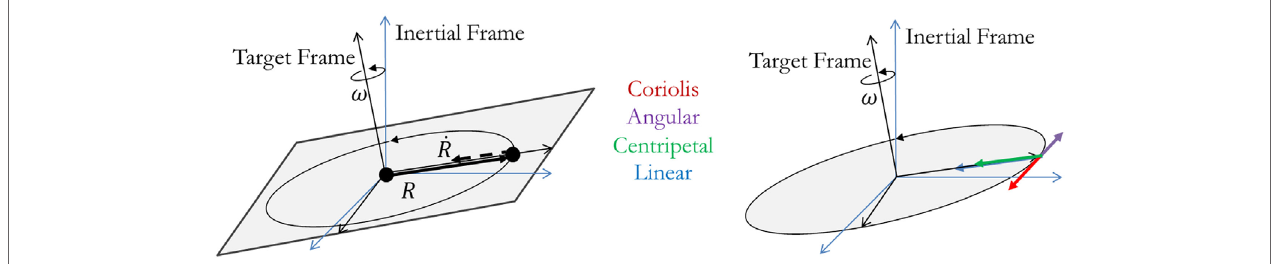
FigUre 2 | Acceleration component diagram: position and velocity vectors of the approaching chaser are shown on the left, and the four acceleration components are shown on the